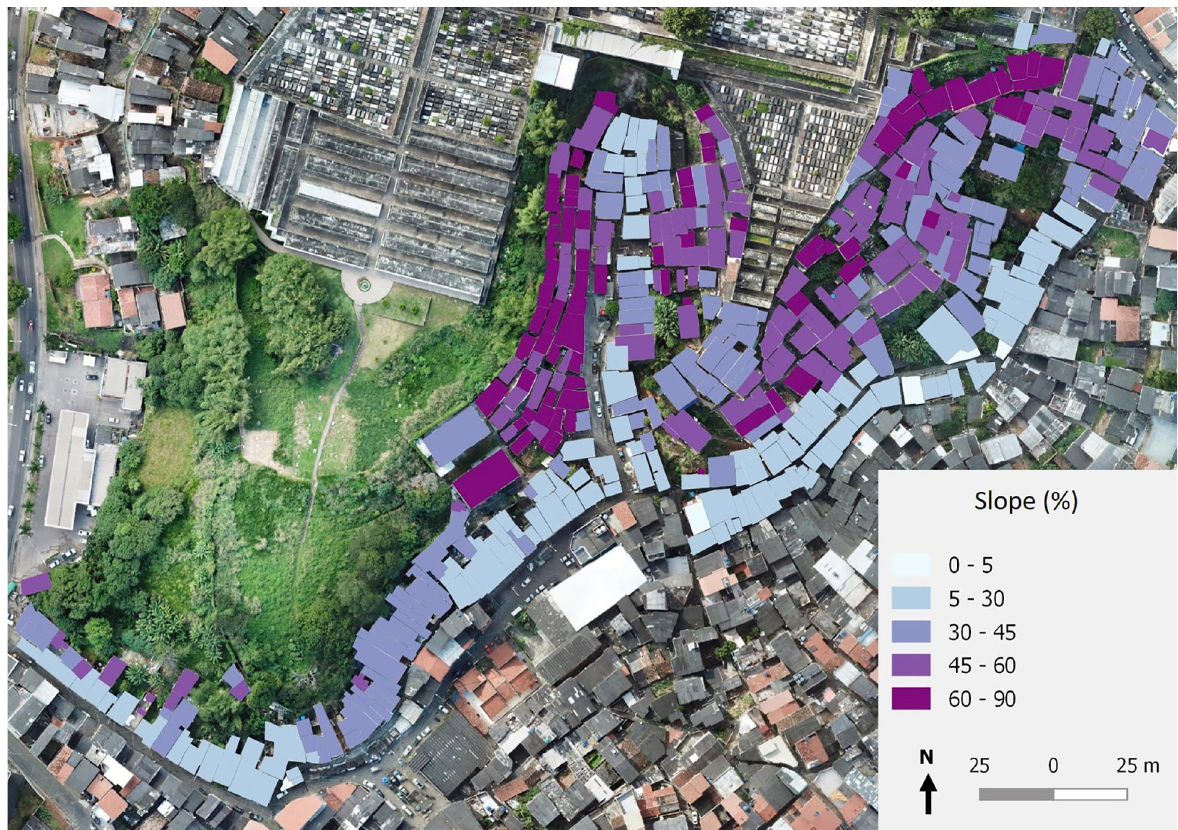
Fig. 4. Terrain slope below the houses in the study area of Alto das Pombas, in